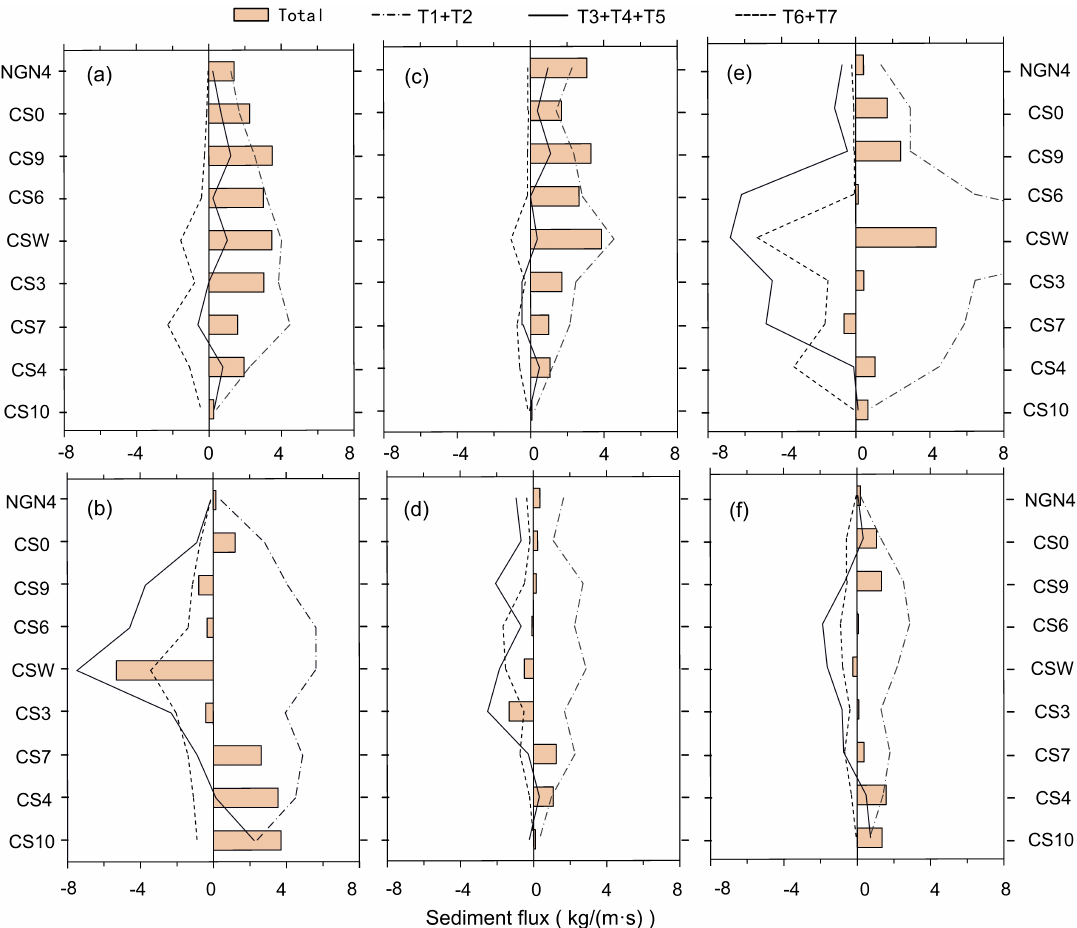
Figure 7. Components of total sediment fluxes at along-channel stations: The ( a – f ) represent six observations, respectively (according to Figure 2). T 1 + T 2 is the advection term, T 3 + T 4 + T 5 is the tidal pumping term and T 6 + T 7 is the vertical circulation term. Positive values denote seaward terms, and negative values denote landward terms.